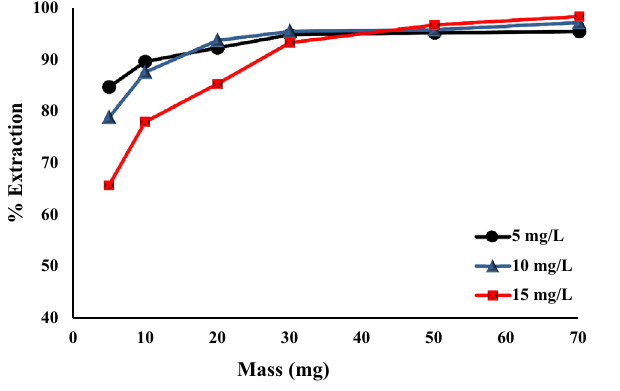
Figure 9. The dosage impact of Fe 0.75 Cu 0.25 -BDC@Alg-MoO 3